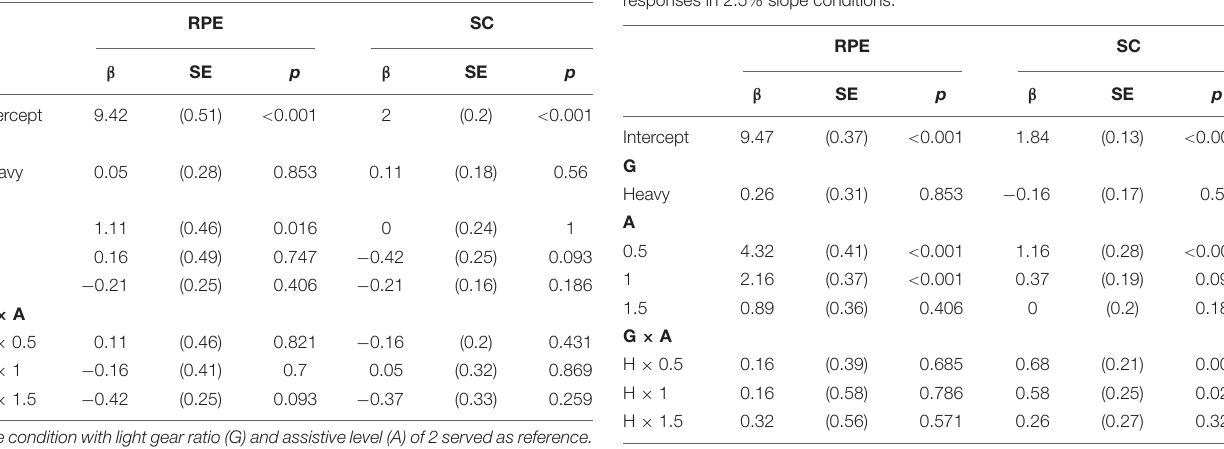
level of 1.5). Significant pairwise RPE differences were found between each assistive levels (level 0.5 > 1 > 1.5 > 2, all p < 0.01), while pairwise SC differences were found between each assistive level, except for levels 1.5 and 2 (level 0.5 > 1 > 1.5 =